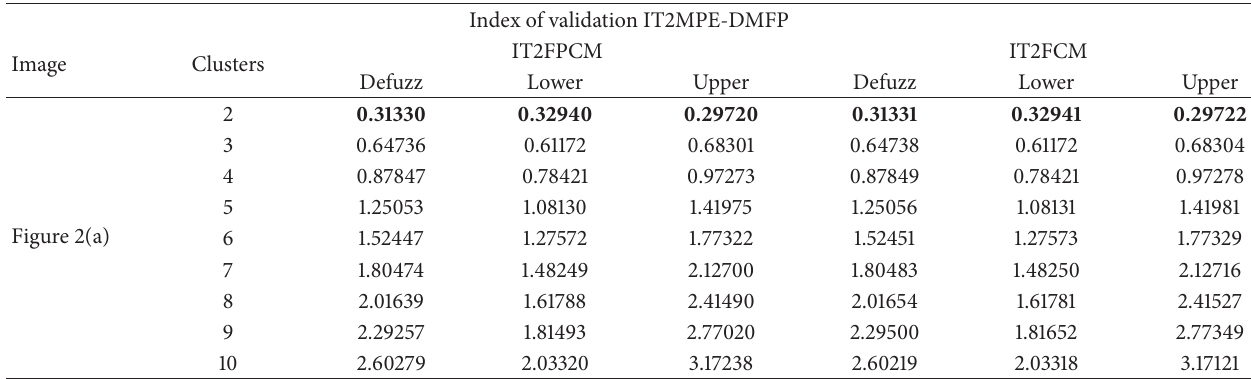
Table 25: Results of the IT2MPE-DMFP validation index to data clustering of image shown in Figure 2(a) using IT2FPCM and IT2FCM algorithm with 𝑚 = [1.5, 2.5] and 𝜂 = [1.5, 2.5] as parameters.